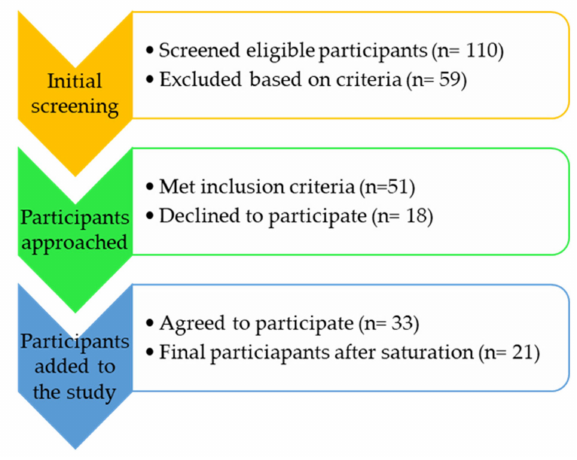
Figure 2. A flow diagram of the participants’ recruitment for the qualitative